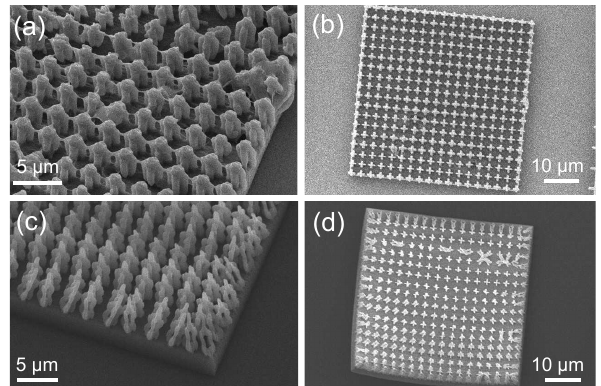
Figure 2. Scanning electron microscope images of single flexure layers which were fabricated with different laser power settings. Images ( a , b ) show two views of a flexure layer which was fabricated using 500 mm/s scan speed with 50% laser power. Images ( c , d ) show the same views of a layer fabricated using 500 mm/s scan speed with 20% laser